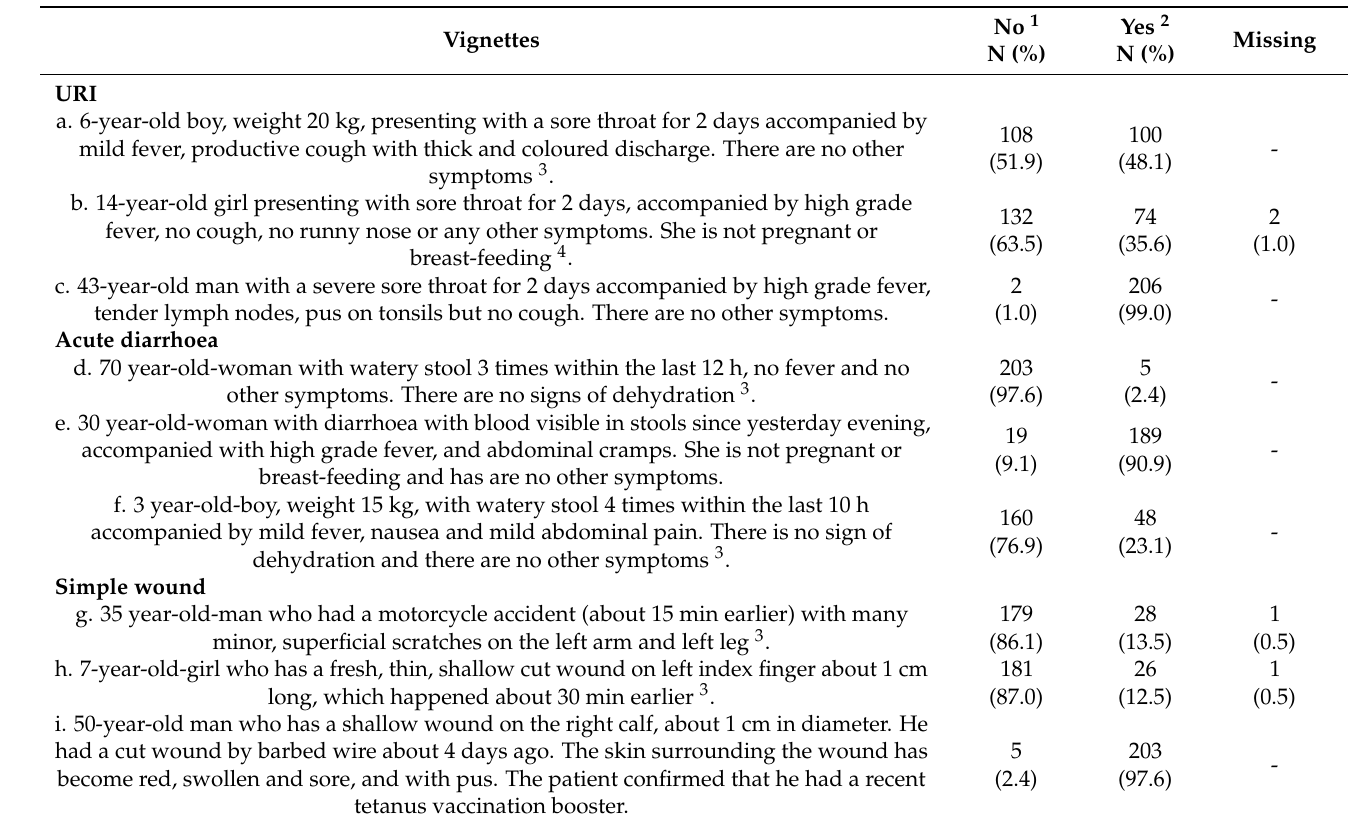
Table 2. Recommendation to supply antibiotics based on vignettes.